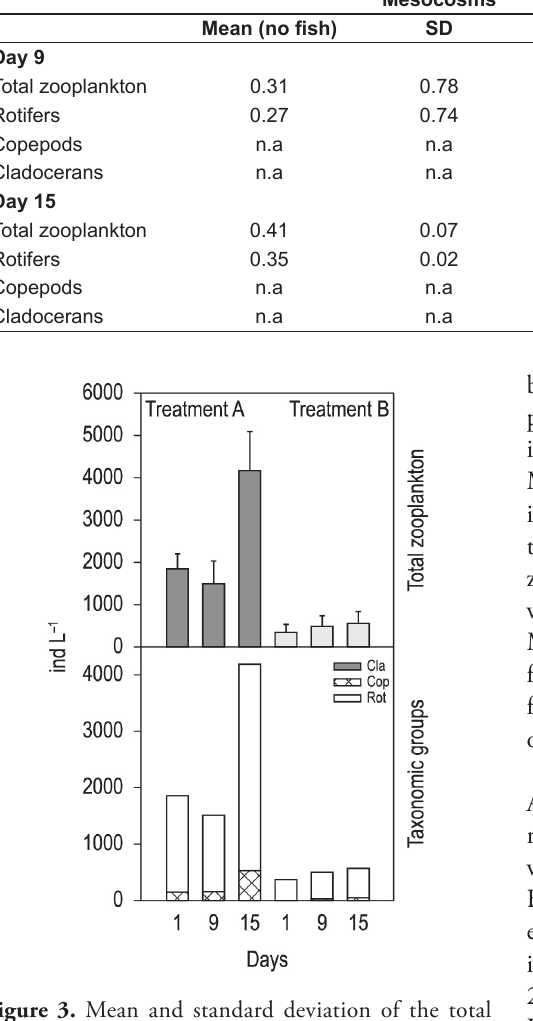
Figure 3. Mean and standard deviation of the total zooplankton density and taxonomic groups in the mesocosms on day 1 (start), 9 (middle) and 15 (end of the experiment). Cla=cladocerans, Cop=copepods, and Rot=rotifers. Treatment A (with fish), treatment B (no